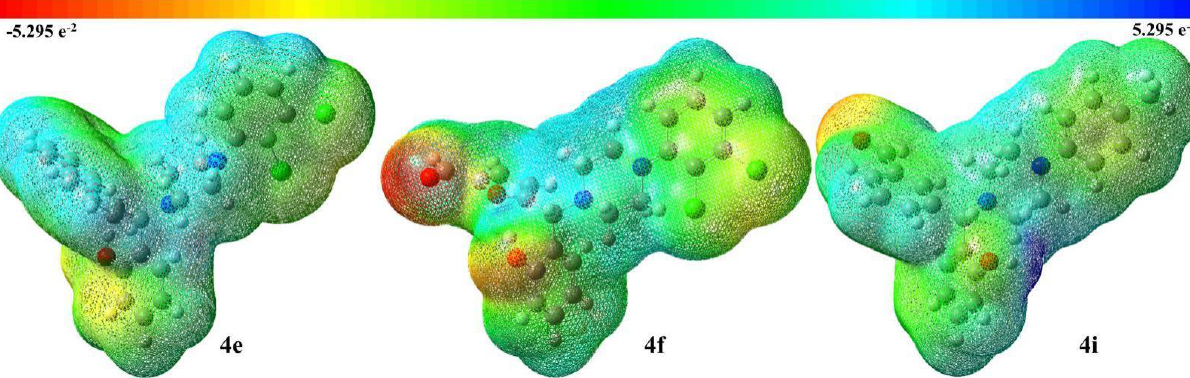
Figure 5. Molecular electrostatic charge distribution plots for 4e, 4f and 4i (highly active molecules) with an isovalue of 0.004 Å −3 .